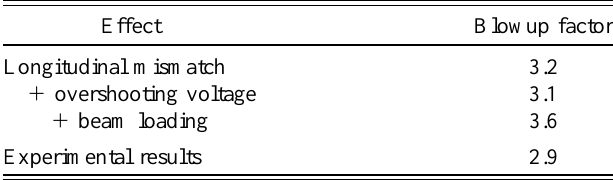
TABLE IV. Blowup factor of the longitudinal